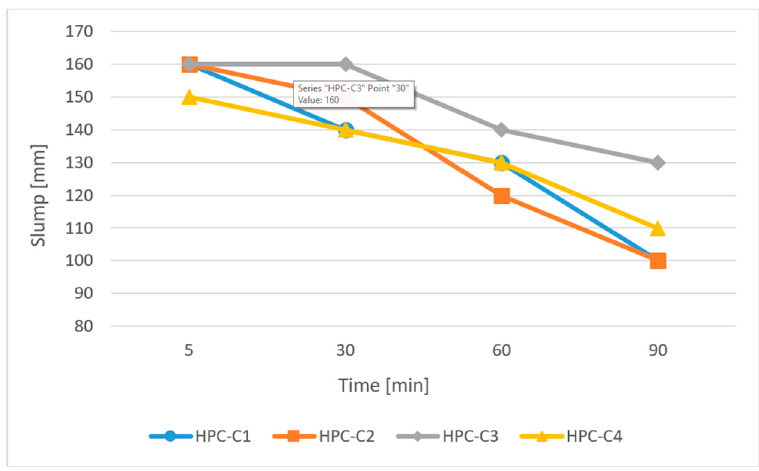
Figure 13. Consistency of SCC concrete mixtures in time.